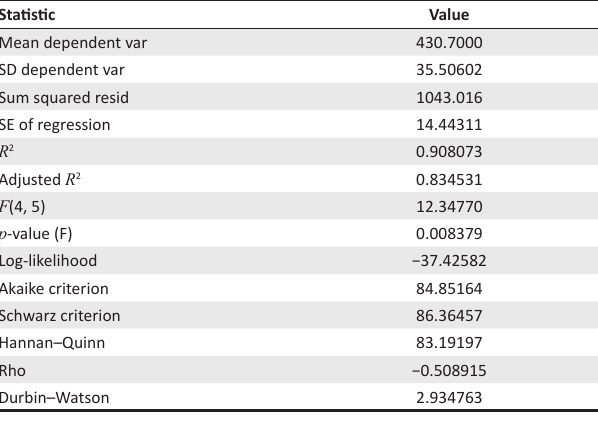
TABLE 3b: Summary statistics for fatalities